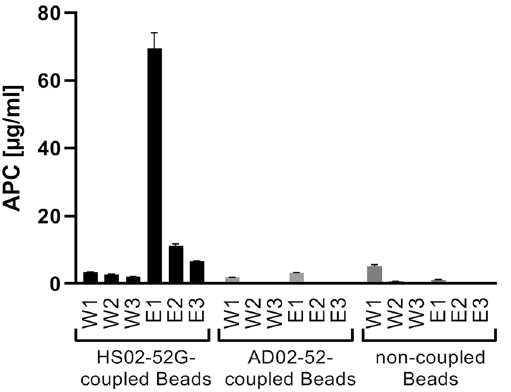
Figure 4. Specificity of aptamer-loaded beads. Capturing and elution results of APC using MyOne beads coupled to APC-specific HS02-52G aptamer, negative control sequence AD02-52, or non-coupled MyOne beads. The amount of APC which was captured from binding buffer containing 10 µg APC in 500 µl of binding buffer (5 µg/ml) and released during consecutive steps of washing (W1 to W3) or elution (E1 to E3) was quantified by an activity assay using an APC standard curve. Data are shown as mean ± SD of three measurements.